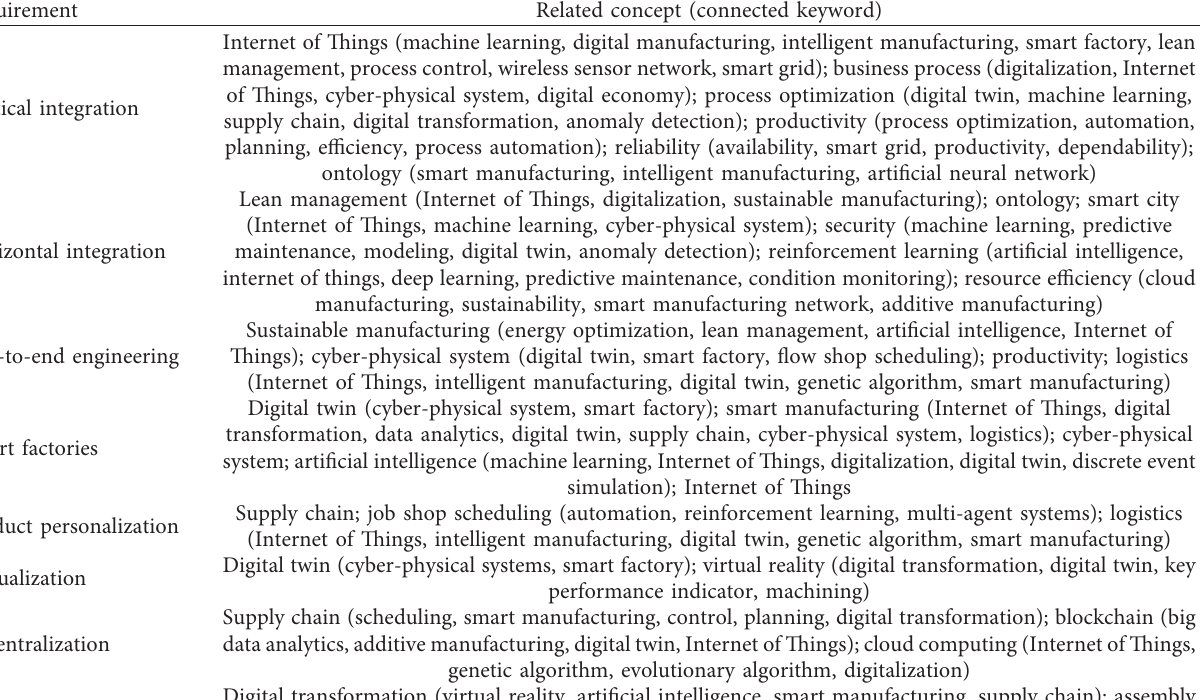
Table 4: Network analysis of keywords to show the concepts related to the different requirements as well as the keywords related to the concept in